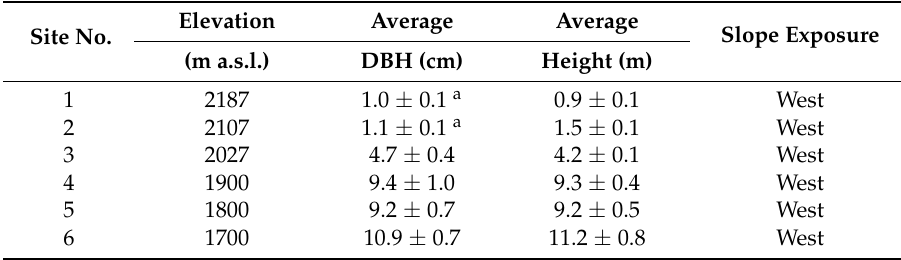
Table 1. Characteristics of the plots and the sampling trees Betula ermanii Cham. (mean ± 1 standard deviation; n = 5 trees) on the Changbai Mountain (Jilin, NE